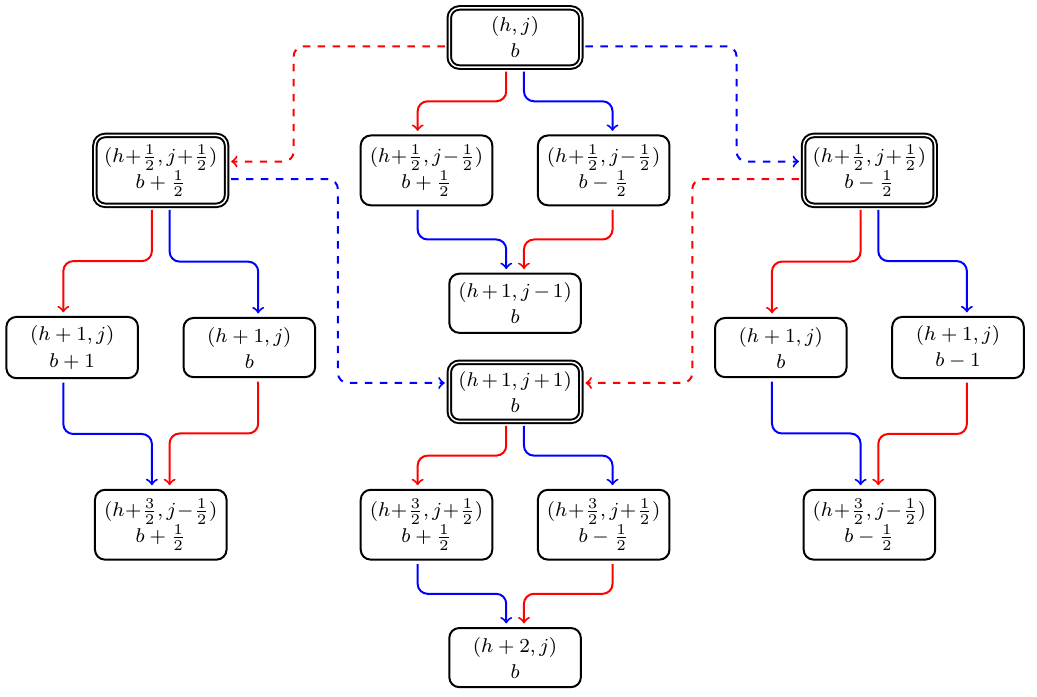
Figure 2. A generic psu(1 , 1 | 2) representation [ h, j ] b contains sixteen irreducible su(1 , 1) ⊕ su(2) submodules, which are here represented by their charges under su(1 , 1) ⊕ su(2) and under su(2) • . In this figure the charges of these submodules are depicted together with their eigenvalues under J • . The solid red (blue) arrows indicate the action of the generators Q 1 ( ˙ Q 2 ) and the dashed red (blue) arrows indicate the action of generators Q 2 ( ˙ Q 1 ). Note that not all such actions are depicted. For h = j the representation ( j, j ) b becomes reducible and splits into four short representations with highest weight states corresponding to the states in the double